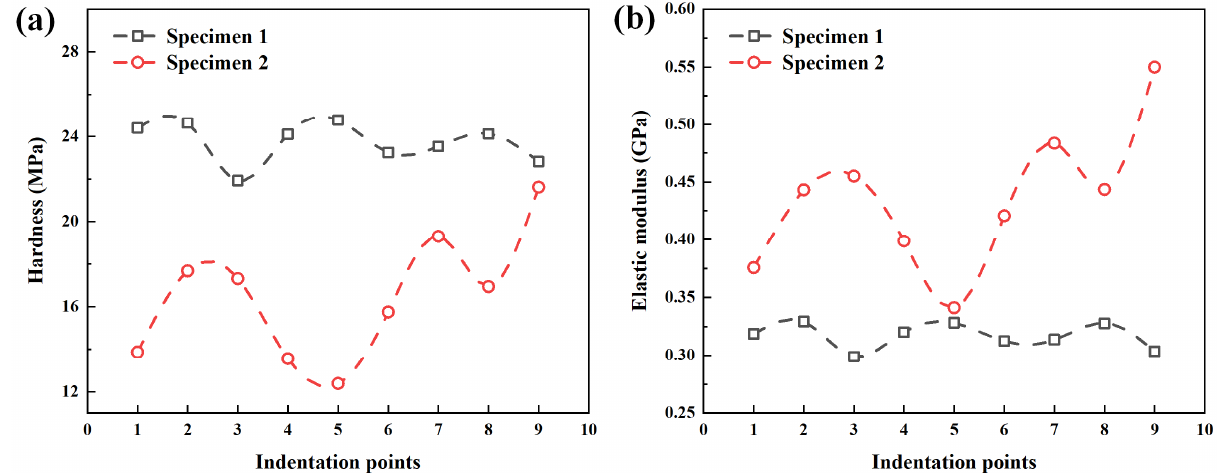
Figure 7. Mechanical parameters of specimens based on the indentation work method: ( a ) hardness; ( b ) elastic modulus.